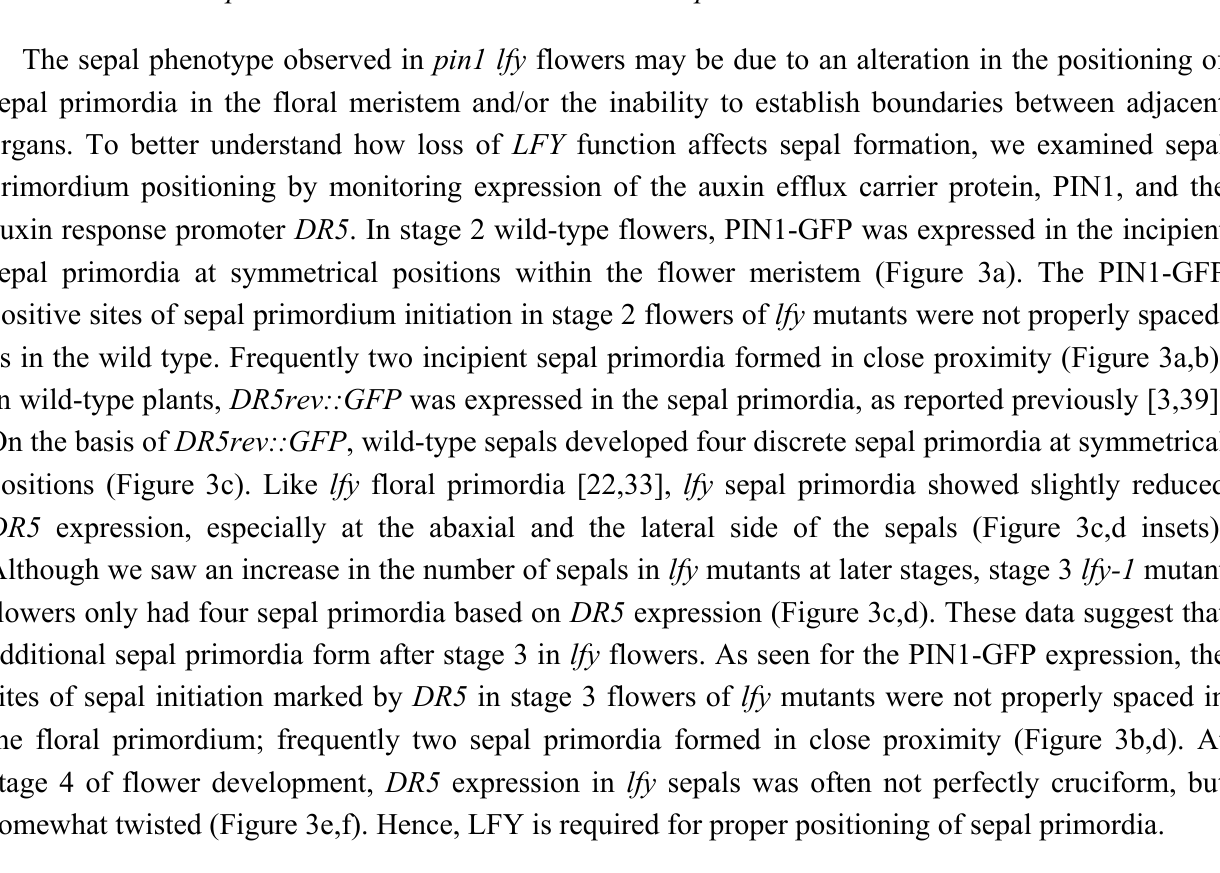
Figure 3. Floral organ primordium initiation in lfy loss-of-function mutant